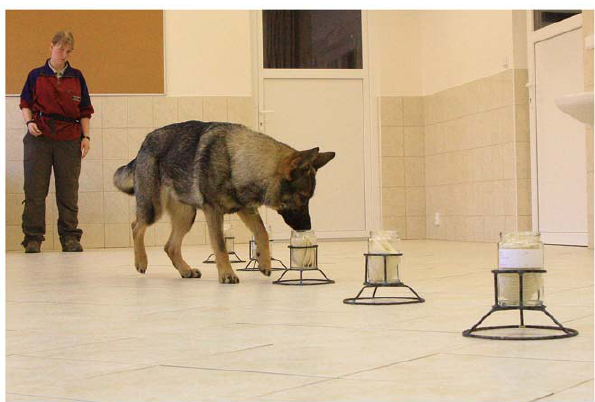
Figure 1. A photograph of the dog sniffing the scent sample in a